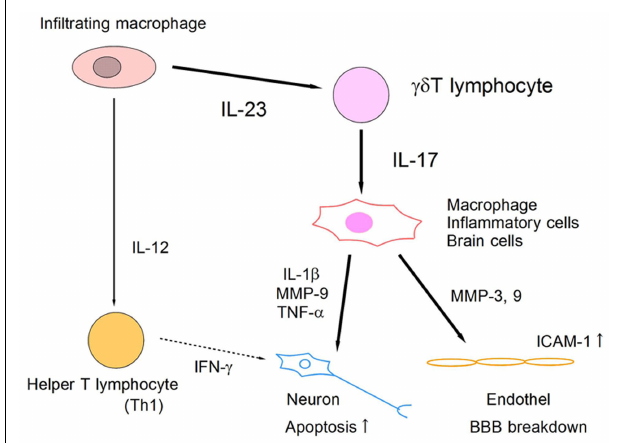
FIGURE 4 | Schematic model of IL-23/IL-17 inflammatory pathway in ischemic brain tissue. Infiltrating macrophages produce IL-23 and IL-12, which induce IL-17-producing γδ T lymphocytes and IFN- γ -producing helperT lymphocytes (Th1), respectively. IL-17 from γδ T lymphocytes acts on macrophages and brain cells directly, and promotes the expression of inflammatory mediators that enhance apoptotic neuronal cell death and BBB breakdown.